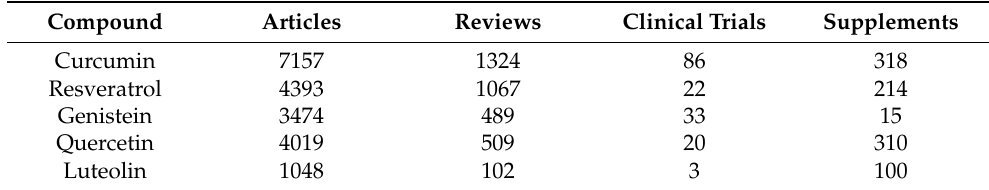
Table 1. There is a lot of interest in curcumin, resveratrol, genistein, quercetin, and luteolin in the context of cancer. Compound